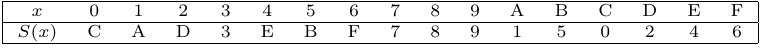
Table 2: S-box of